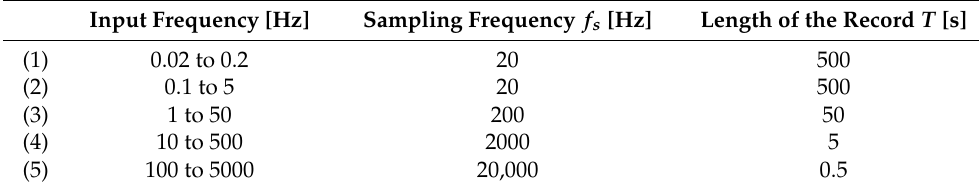
Table 2. Segmented frequency range of the swept sinusoidal input.